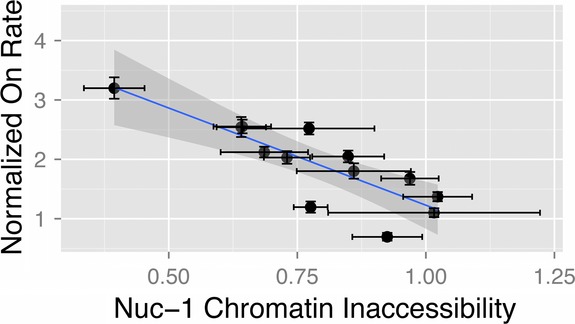
Nuc-1 occupancy can explain variation in promoter activation rates across genomic positionsChromatin state around the transcription start site is strongly correlated with the promoter activation rate. Unlike other regions of the HIV-1 promoter (see Supplementary Fig S17), chromatin inaccessibility around Nuc-1 was strongly correlated with the frequency of promoter transition from the Off to On state (slope = −1.1 ± 0.5, R2 = 0.69, rs = −0.85, P < 0.001). Clones with more closed chromatin produced more infrequent transitions from the Off to On promoter state. qPCR experiments were performed in triplicate, and error bars reflect the standard deviation from the mean. Error bars on ka represent 95% confidence intervals estimated using 1.92 log-likelihood ratio units. rs represents the Spearman correlation coefficient for the explanatory and response variables in each pairwise regression, and P-values represent support for correlation.